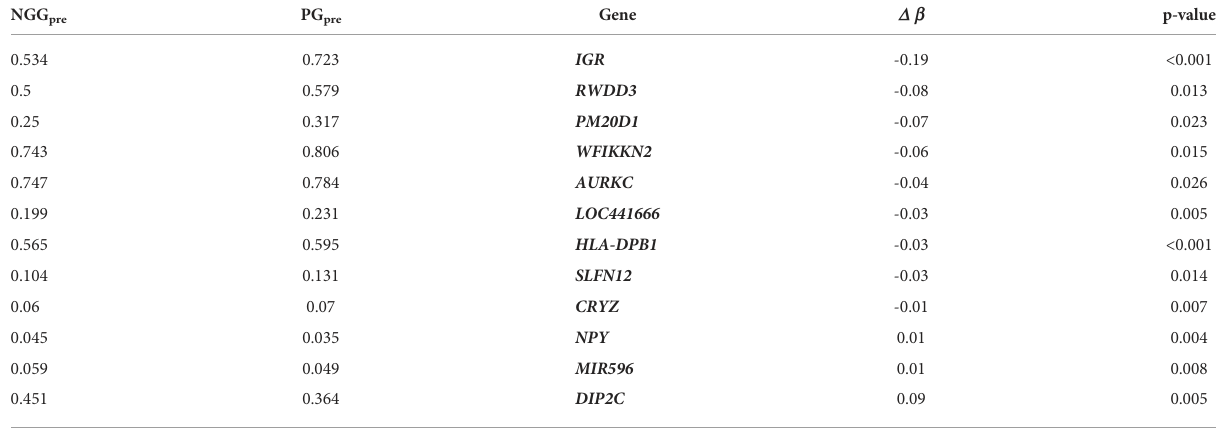
TABLE 4 Differentially Methylated Regions (DMRs) of the Prediabetes Group (PG) compared to the Normal Glucose Group (NGG) before 14 weeks of physical activity intervention. NGG pre PG pre Gene D